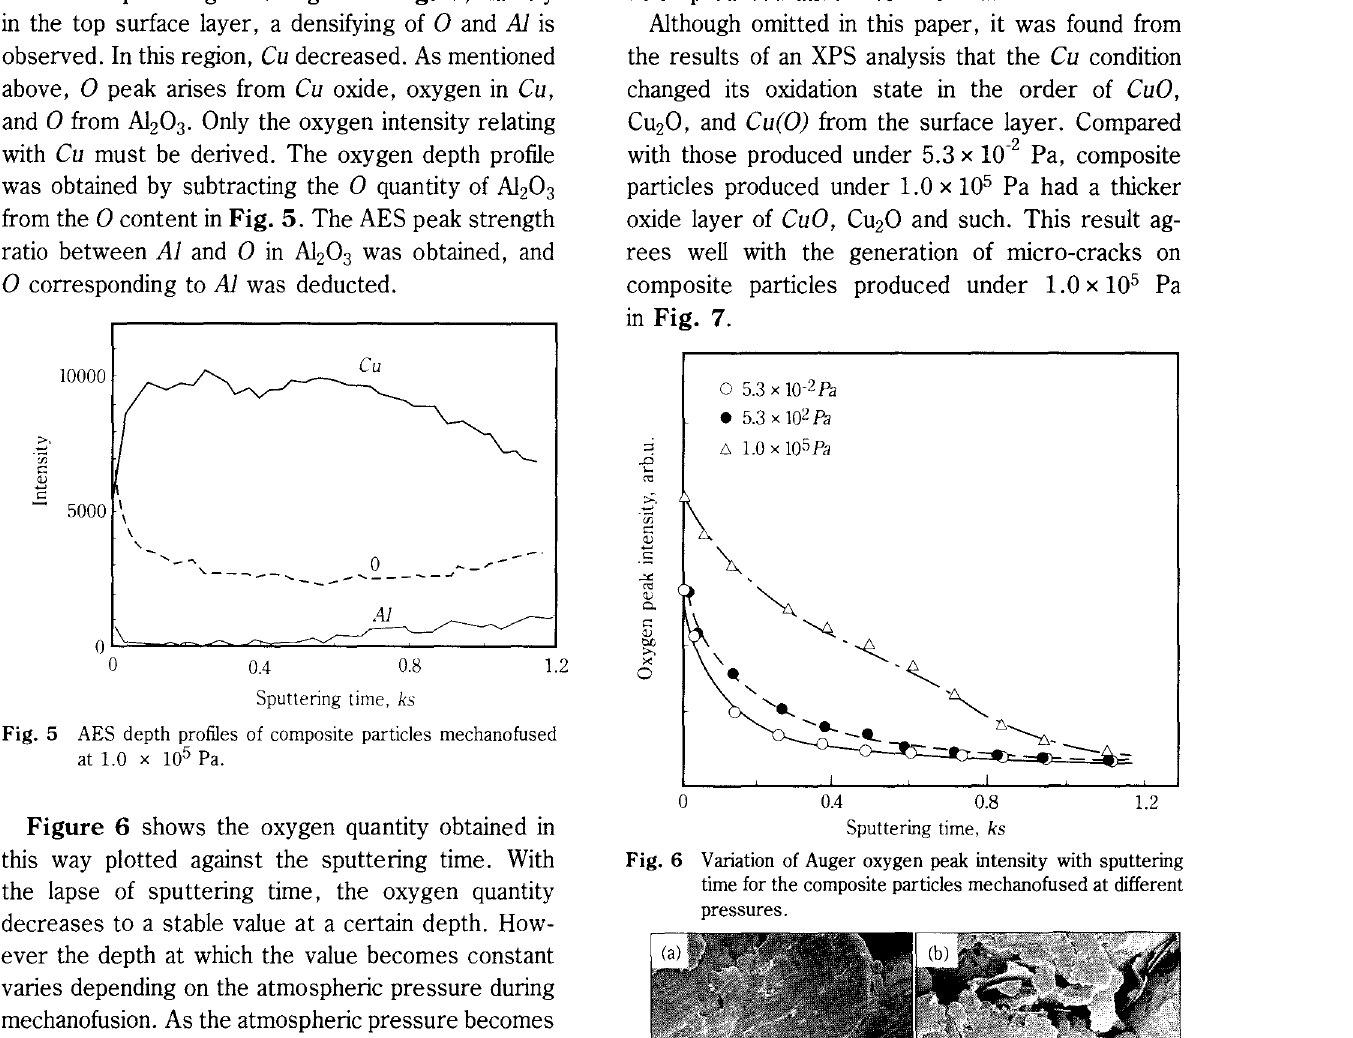
Fig. 6 Variation of Auger oxygen peak intensity with sputtering time for the composite particles mechanofused at different pressures.